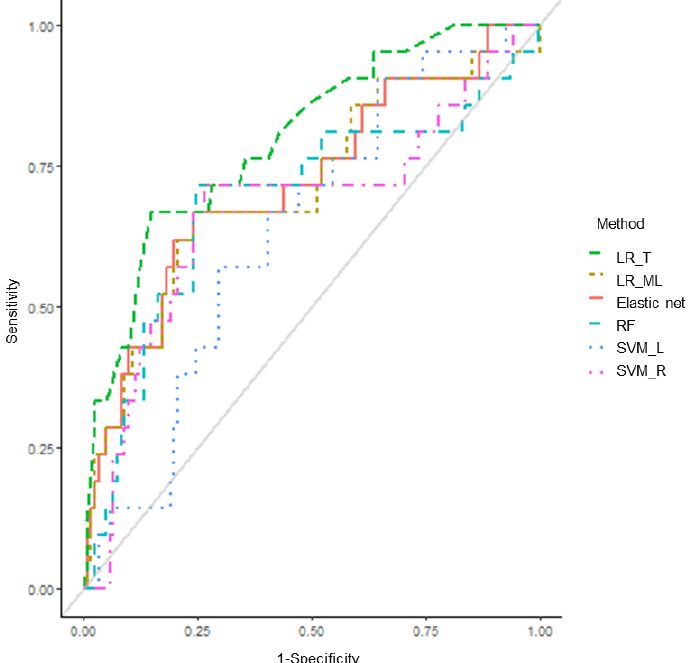
Figure 1. Area under the receiver operating characteristic curve (AUROC) for bleeding complica- tions at therapeutic INRs. LR_T: traditional logistic regression; LR_ML: machine learning-based lo- gistic regression; RF: random forest; SVM_L: support vector machine–linear kernel; SVM_R: sup- port vector machine–radial kernel.